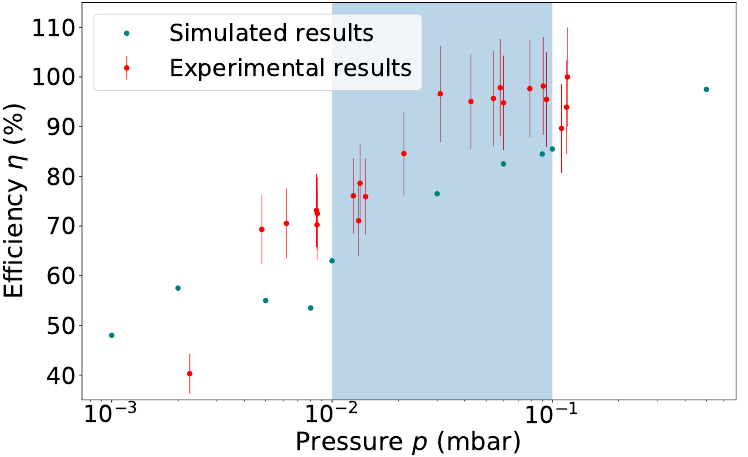
Figure 4. Experimental and simulated SRFQ and mRFQ transmission efficiency as a function of pressure p . Necessary p conditions for a matched hypersonic jet of Mach number 7–8 are highlighted by the region of interest in light